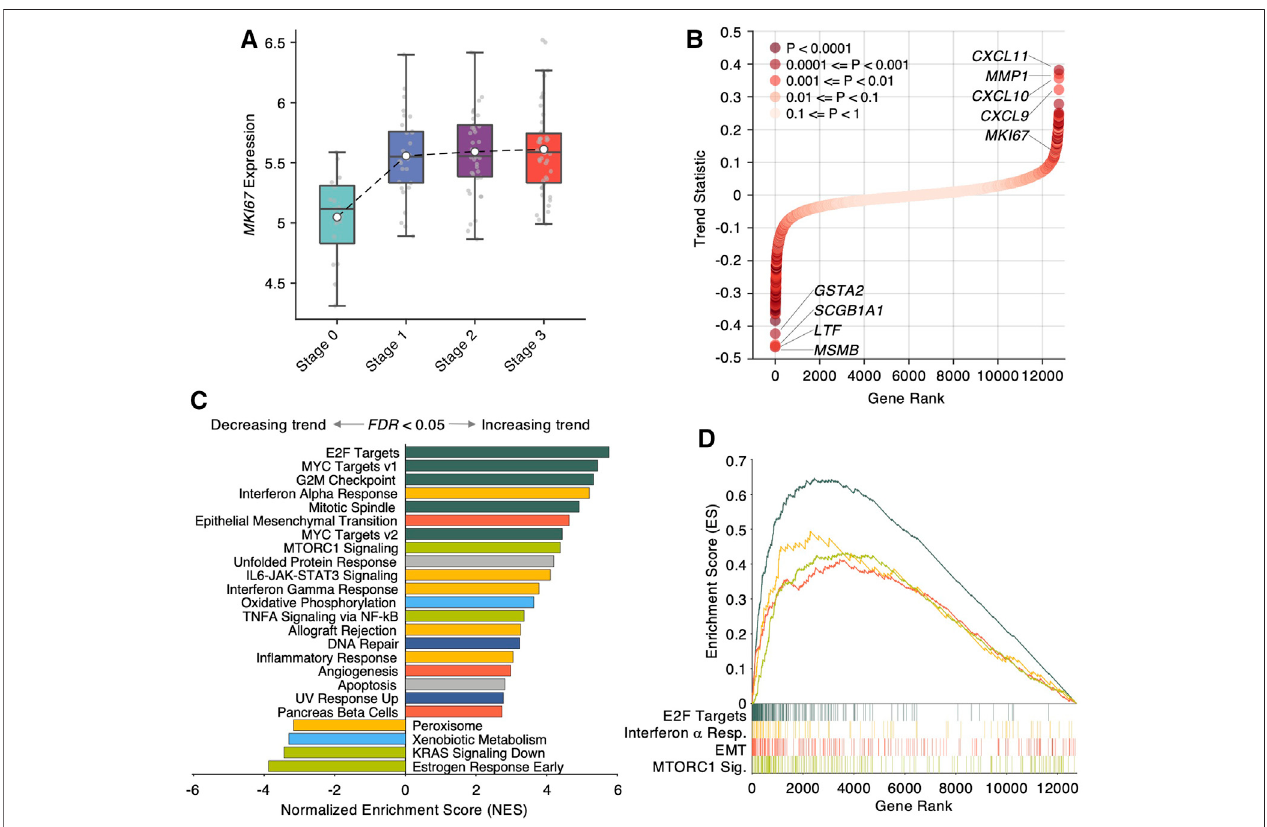
FIGURE 2 | Trend analysis identi fi es transcriptional signatures in nasopharyngeal carcinoma progression. (A) Boxplot of MKI67 expression in different NPC progressionstages. (B) Scatterplotoftrendstatisticofeachgene,sortedbyascendingorder.Colorsdenotetrendsigni fi cance,derivedby10,000permutationtests. (C) BarplotofNormalizedEnrichedScore(NES)derivedfromGSEA(GeneSetEnrichmentAnalysis)using50cancer-hallmarkgenesets.ThegenesetswithFDR < 0.05are shown. Positive/negative NES denotes increasing/decreasing trend in NPC progression. Colors denote the functional category of each gene set. (D) Enriched score ranked by trend statistics. Four representative gene sets in different functional categories are